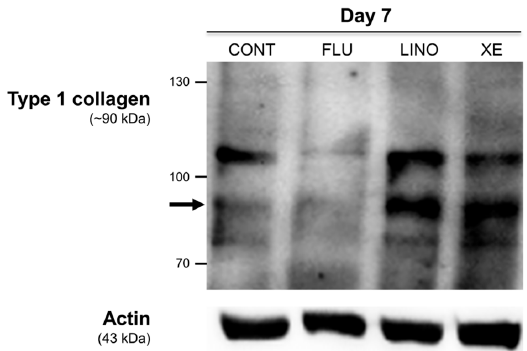
Figure 14. Induction of intracellular type 1 collagen by K V 7 channel during osteoblast differentiation in MG-63 cells. Western blot analysis demonstrated that 30 μ M of linopirdine or 10 μ M of XE991 considerably increased the expression of type 1 collagen on day 7 of osteoblastic induction, while 30 μ M of flupirtine attenuated type 1 collagens. CONT: non-treated controls; FLU: flupirtine; LINO: linopirdine; XE: XE991.